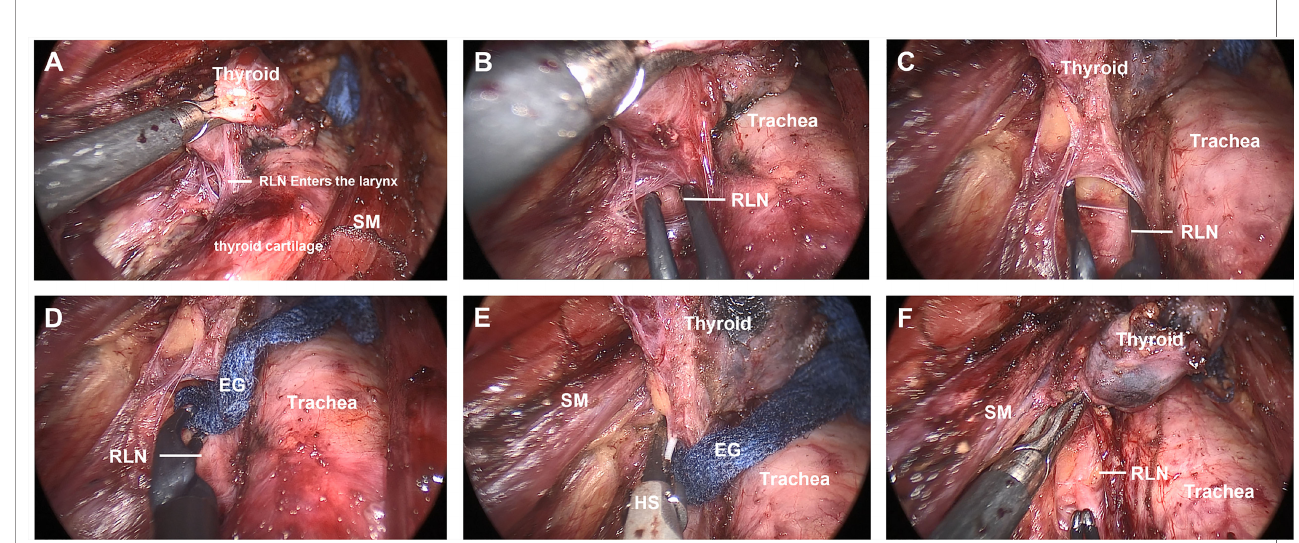
FIGURE 5 | INTP strategy was applied in transoral endoscopic thyroidectomy. (A) Exposure of superior pole of thyroid lobe. (B) Exposure of one segment of RLN. (C) Establish the “ neural tunnel. ” (D) Endoscopic gauze was stuffed. (E) UltraCision implementation upon the gauze. (F) Completion of RLN separation pathway. INTP, intraoperative nerve tunnel protecting; RLN, recurrent laryngeal nerve.